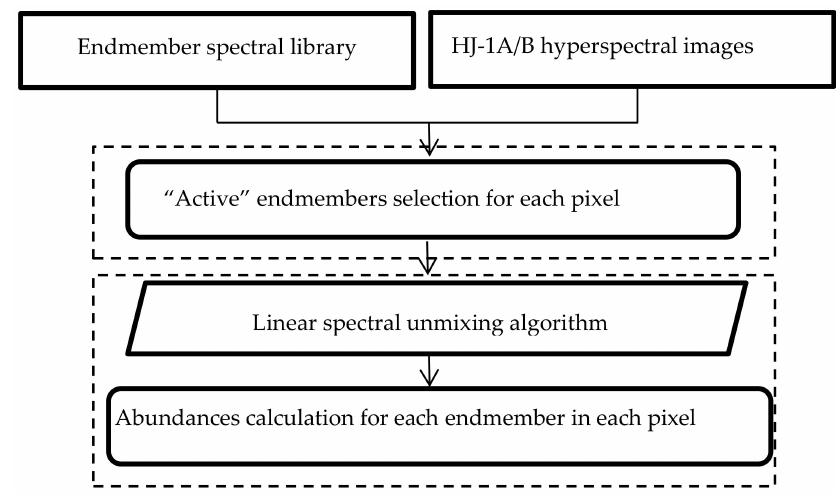
Figure 4. Different land cover maps derived from the full constrained least squares linear spectral mixture model (FCLS-LSMM) ( a ), and the sparse constrained least squares linear spectral mixture model (SCLS-LSMM) ( b ).